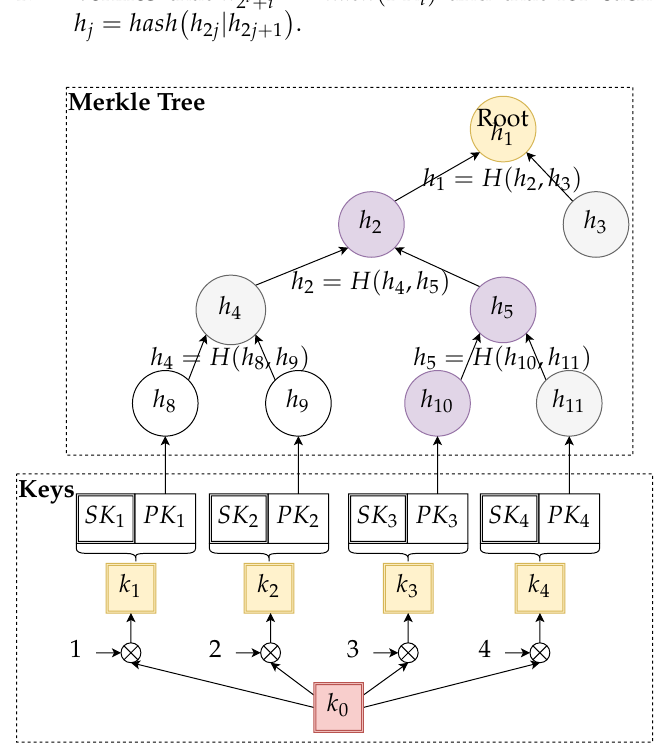
Figure 3. Example of a relevant part of a parallel key structure and Merkle tree authenticator built on top of the precomputed public key